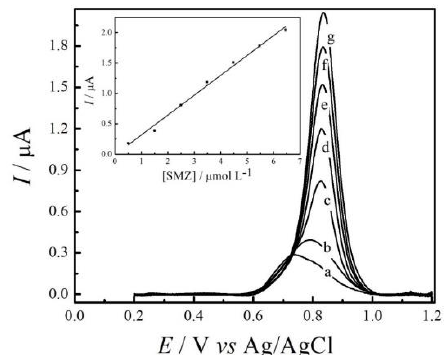
Figure 10. DPV voltammograms for GC/rGO–AuNPs composite electrode, with the optimized parameters. The SMZ concentrations in µmol L −1 are: (a) 0.5, (b) 1.5, (c) 2.5, (d) 3.5, (e) 4.5, (f) 5.5, and (g) 6.5. Inset: linear dependence of the peaks current with SMZ